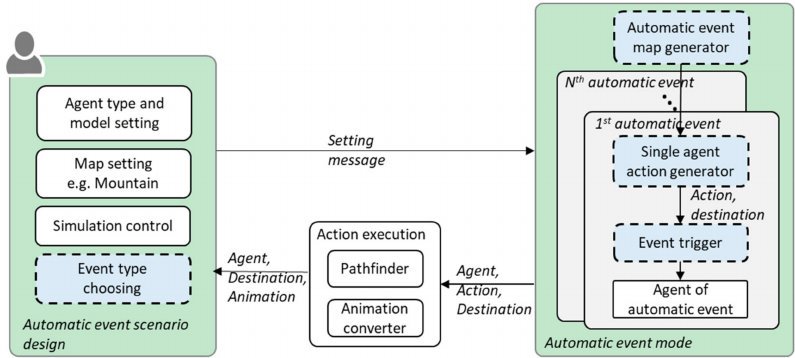
Figure 4. Overview of automatic event